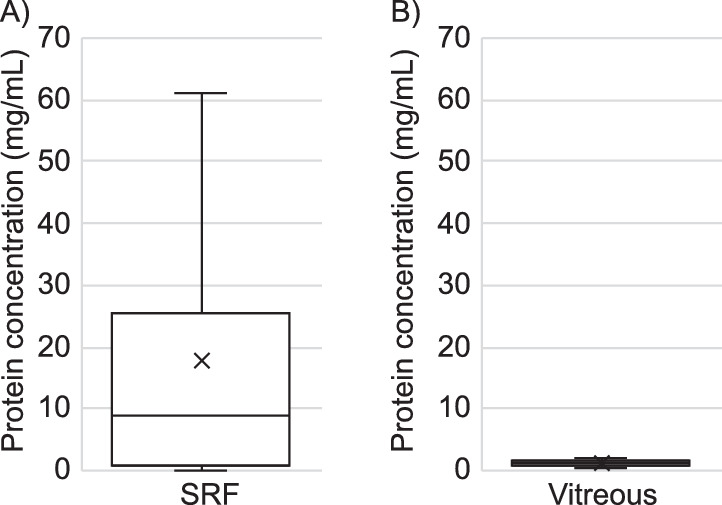
The protein concentration in SRF is high compared to vitreous humor. Box-and-whiskers plot showing the distribution of protein concentration of (A) SRF and (B) vitreous. (A) The SRF samples had a mean ± SD of 17.9 ± 22 mg/mL and displayed a maximum and minimum of 61.0 and 0.02 mg/mL, respectively. (B) The 20 vitreous samples had a mean ± SD protein concentration of 1.2 ± 0.4 mg/mL and a maximum and minimum of 2.0 and 0.6 mg/mL, respectively.